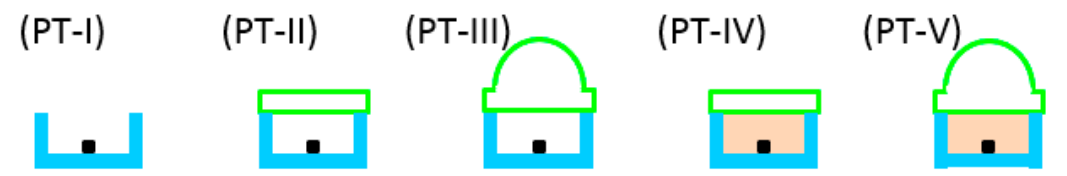
Figure 1. Structure diagrams of the five package types of the Deep-ultraviolet light emitting diodes (DUV-LEDs).